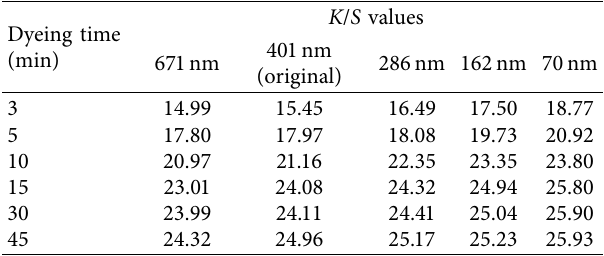
Table 5: K / S values of dyed fabrics with disperse orange 31 at diferent particle sizes and dyeing